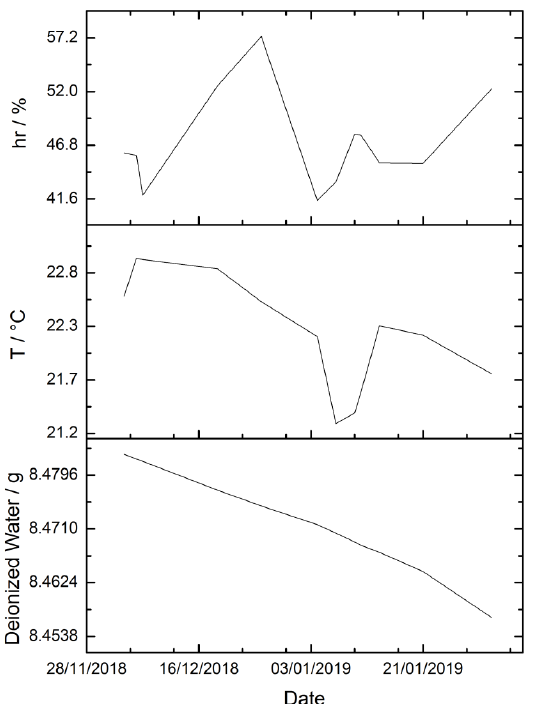
Figure 6. Simultaneous variation of relative humidity, temperature and balance reading.